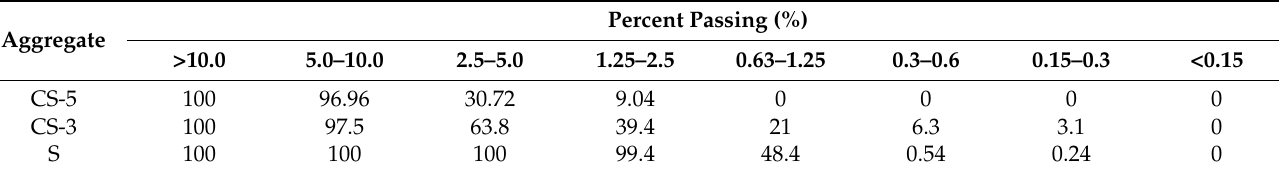
Table 3. Content of aggregate particles passing through the sieve.